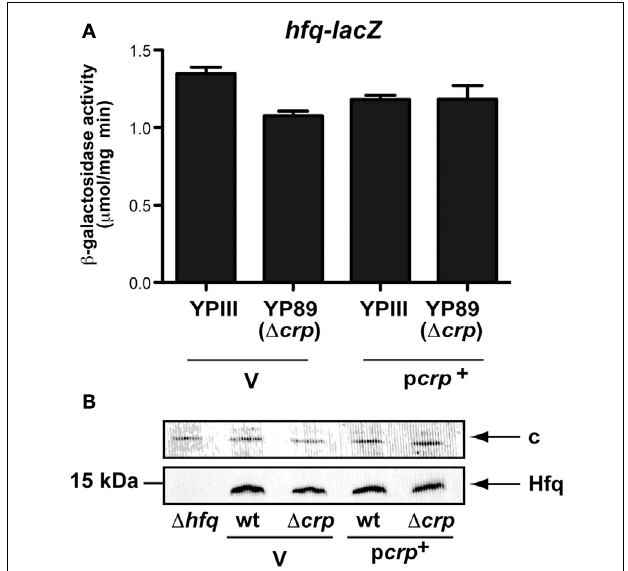
FIGUREA3 |Analysis of hfq transcription in the presence and absence of Crp in Y. pseudotuberculosis . (A) The empty vector pAKH85 (V) or its crp + derivative pAKH37 (p crp + ) were transformed into Y. pseudotuberculosis YPIII andYP89 ( ∆ crp ) harboring an hfq-lacZ fusion (pAKH105).The bacteria were grown overnight in LB medium at 25˚C. β -Galactosidase activity from overnight cultures was determined and is given in µ molmin − 1 mg − 1 for comparison.The data represent the average ± SD from at least three different experiments each done in duplicate. (B) Expression of Hfq in the presence and absence of Crp.Whole cell extracts from overnight cultures of Y. pseudotuberculosis wildtype strainYPIII and the mutant strainsYP89 ( ∆ crp ) harboring the empty vector pAKH85 (V) or the crp -encoding plasmid pAKH37 (p crp + ) grown at 25˚C were prepared, and analyzed by western blotting with polyclonal antibodies directed against Hfq.The negative controlYP80 ( ∆ hfq ) is loaded in the last lane.The loading control for the western blot is marked with